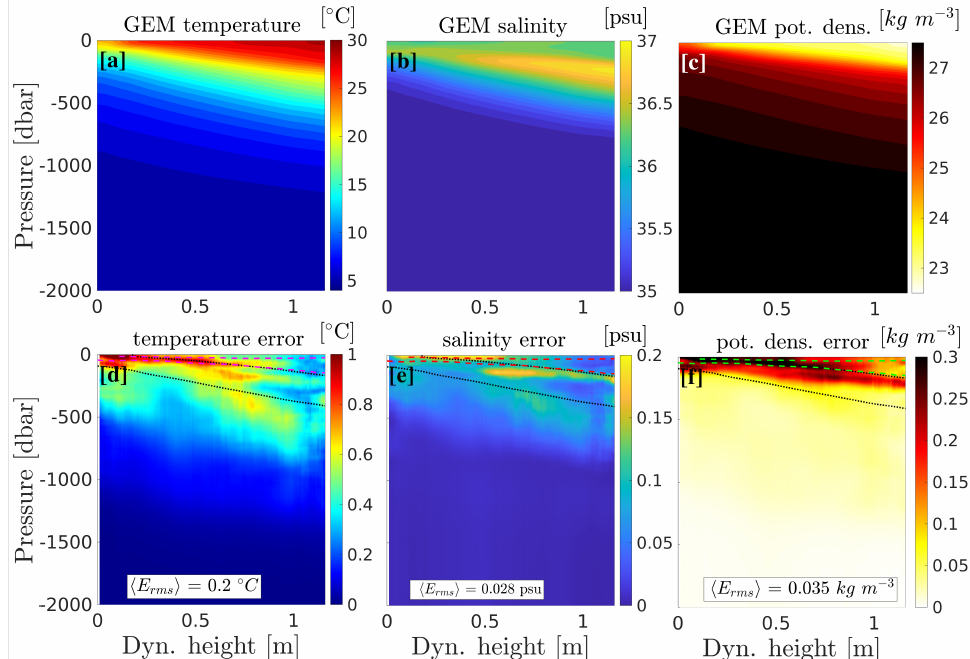
Figure 3. Yearly averaged gravest empirical mode (GEM) fields for temperature ( a ), salinity ( b ), and potential density ( c ). The x-axis represents dynamic height, and the y-axis represents pressure. Dynamic height was shown to be equal to the 2000 dbar-referenced steric height η 2000 and absolute dynamic topography (ADT) in Figure 1d. The root mean squared (RMS) errors are shown in panels ( d – f ) for temperature, salinity, and potential density, respectively. The black dashed lines represent the limits of the SUW potential density range (1024–1026.5 kg m − 3 ), while the red or green dashed lines represent the depth range of the mixed